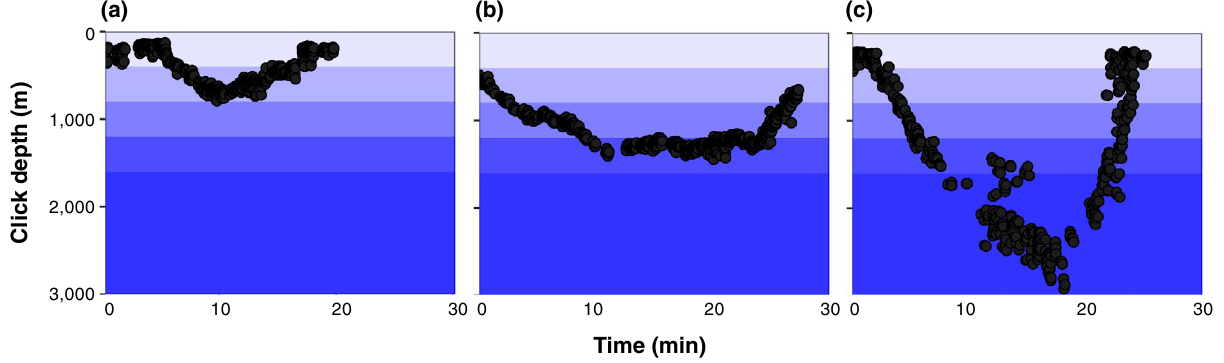
Figure 3. Example of click depths (m) over time (min) for events categorized as ( a ) U shaped and shallow (< 800 m), ( b ) U shaped and medium (800–1600 m), ( c ) U shaped and deep (> 1600